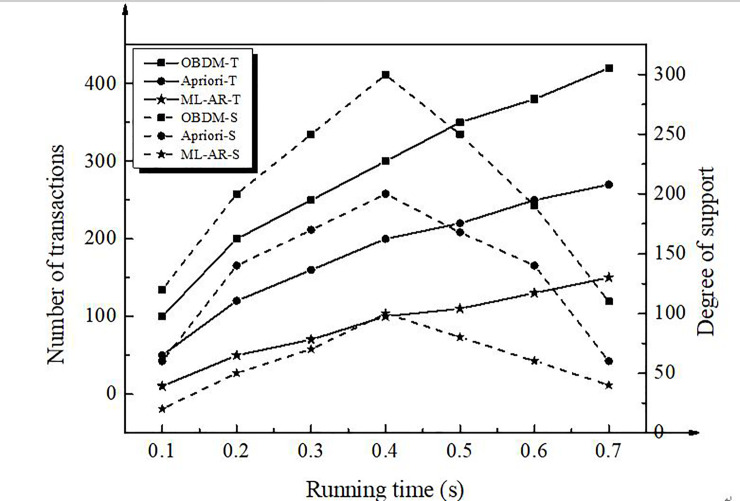
Comparison results of several algorithms on the number of transactions and support (In the figure, the suffix -T indicates the number of transactions, and the indicator is represented by a solid line; the suffix -S indicates the support, and the indicator is represented by a dotted line).